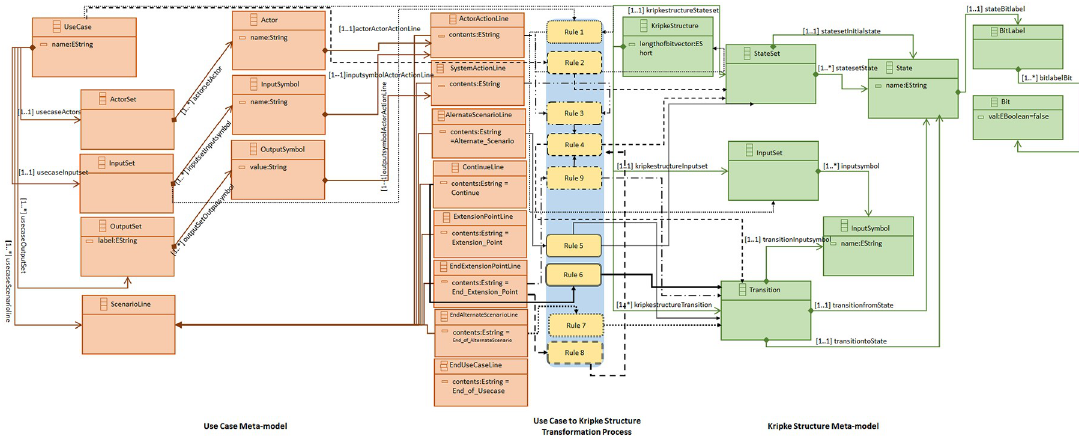
Fig 6. Use case to Kripke structure